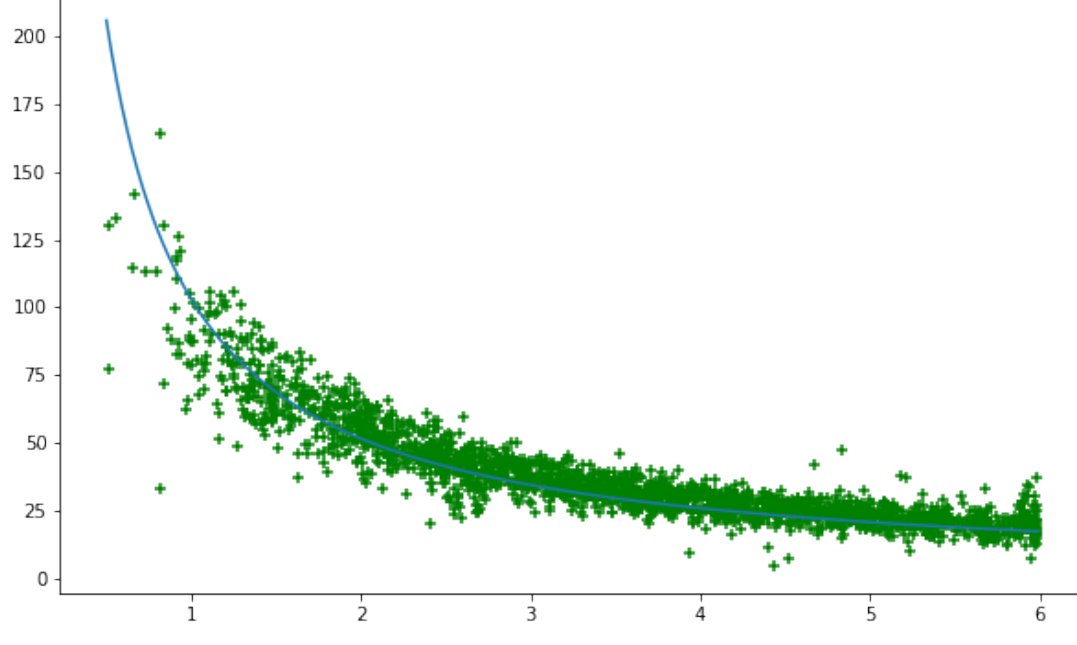
Figure 7. Scatter chart of distance measured using depth data (horizontal axis), meters vs ear-torso Euclidean distance (vertical axis). The blue line is the linear regression based on Equation (1). The distance was recorded for less than 5.99 m. One frame every two seconds was collected to avoid too many samples from the same person. Overall, 2120 samples were collected, and people were walking freely in the